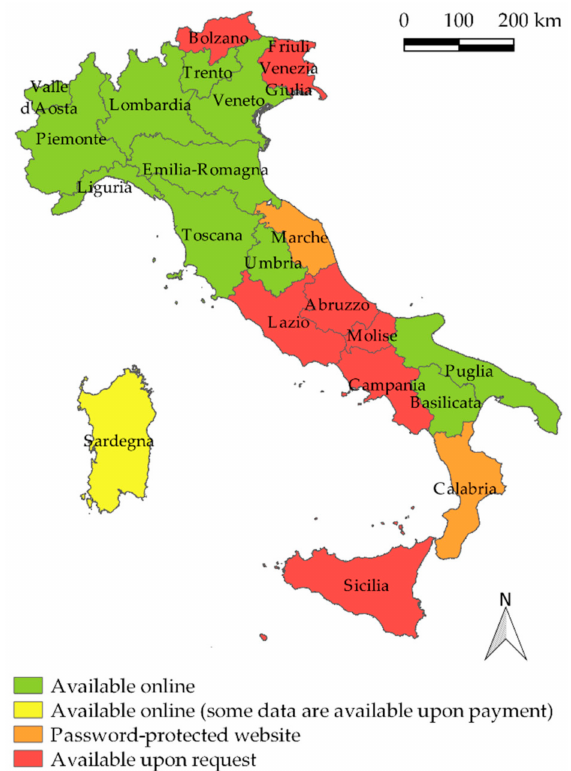
Figure 1. Data policy of the data reported in I 2 -RED for the 21 Italian “regions”. The provinces of Trento and Bolzano, despite being located in the same Region, are shown separately in the map as the data providers and the policies are di ff erent.